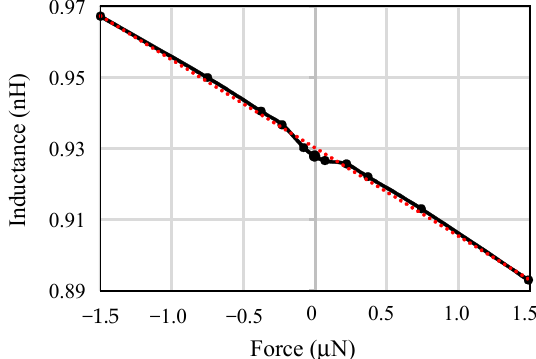
Figure 5. FEM simulation of inductance, L , under external force and deformation.